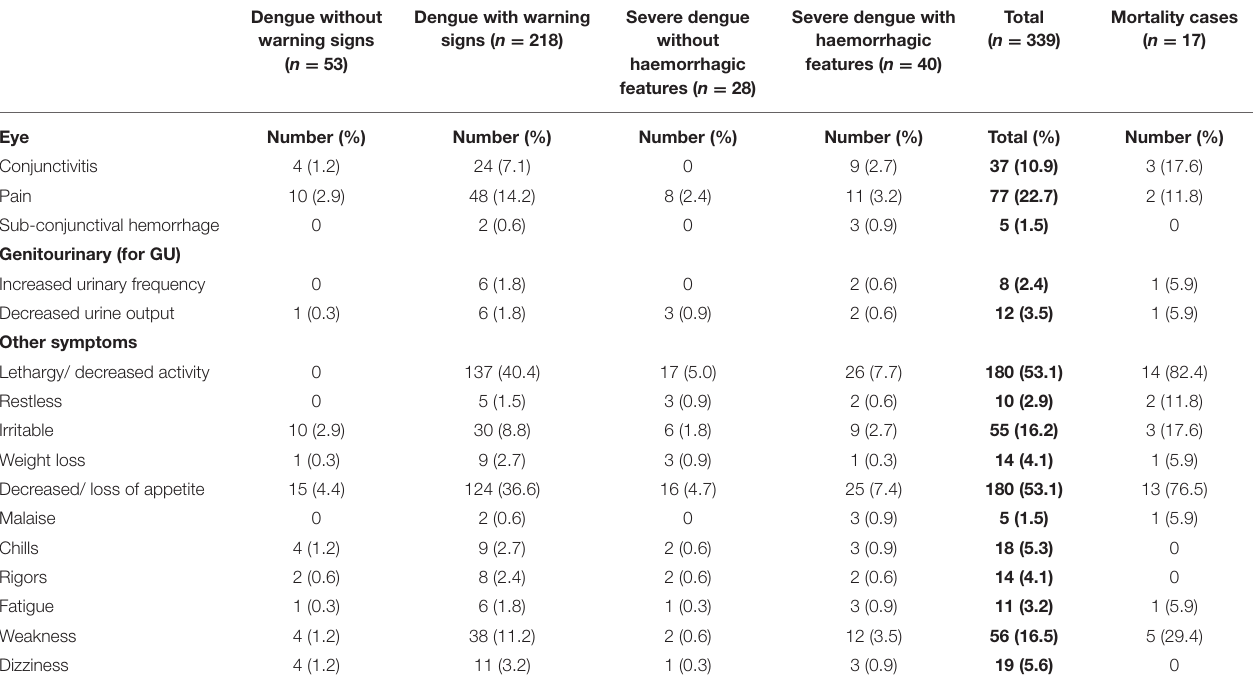
TABLE 3D | Clinical manifestations in pediatric patients hospitalized with suspected and confirmed dengue in the 2018–2019 epidemic. Dengue with warning Dengue without signs ( n = warning signs